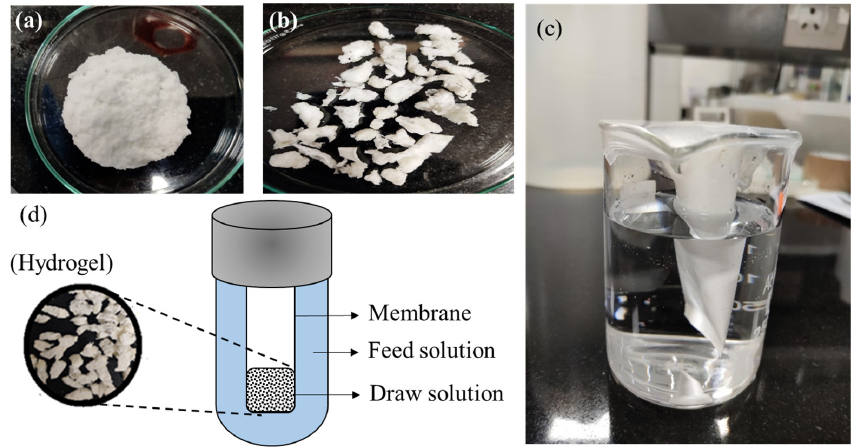
Figure 3. ( a ) Freshly synthesized hydrogel, ( b ) synthesized hydrogel dried at 30 (±1.5) °C for 8 h, ( c ) lab-scale setup, and ( d ) schematic representation of lab-scale setup for forward osmosis using hydrogel as draw solute.